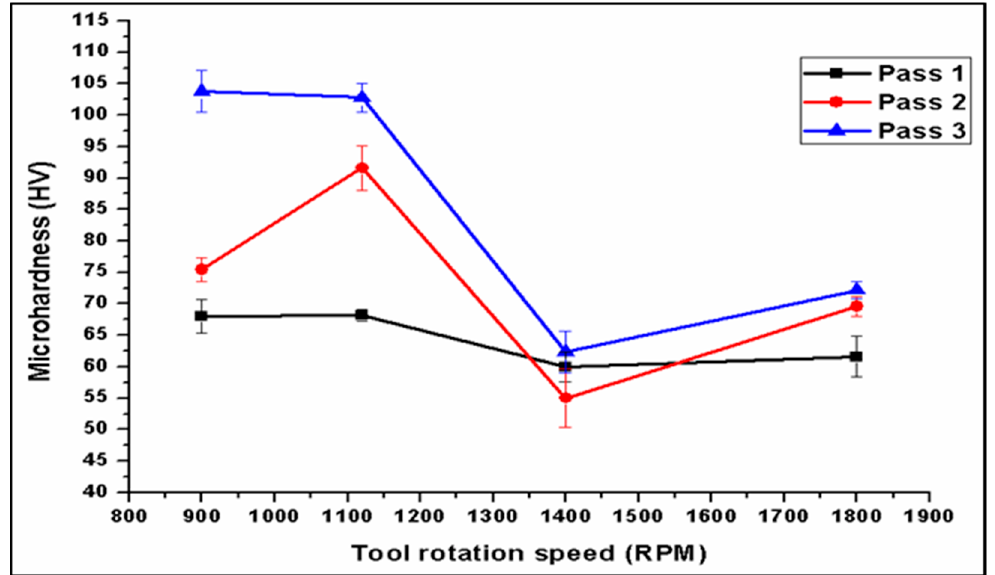
Figure 19. Effect of rotation speed on microhardness through different pass numbers, processed at a 10 mm/s travel speed.